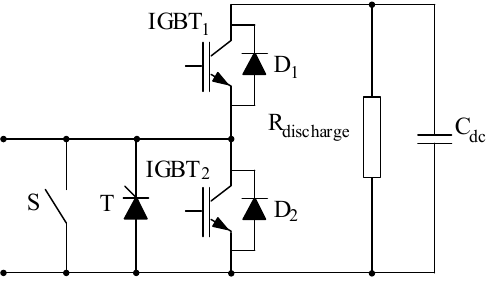
Figure 1. Half-bridge sub-module of the prototype system.